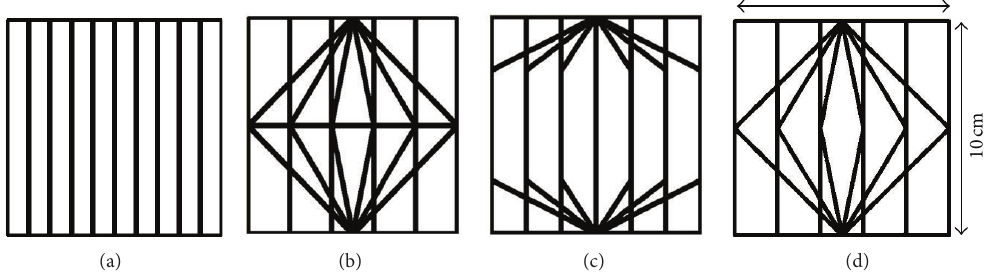
Figure 8: Devised geometries (a) Standard geometry, (b) Geometry 2, (c) Geometry 3, and (d) Geometry 4. The output terminal is supposed to be located at the same position as in Figure